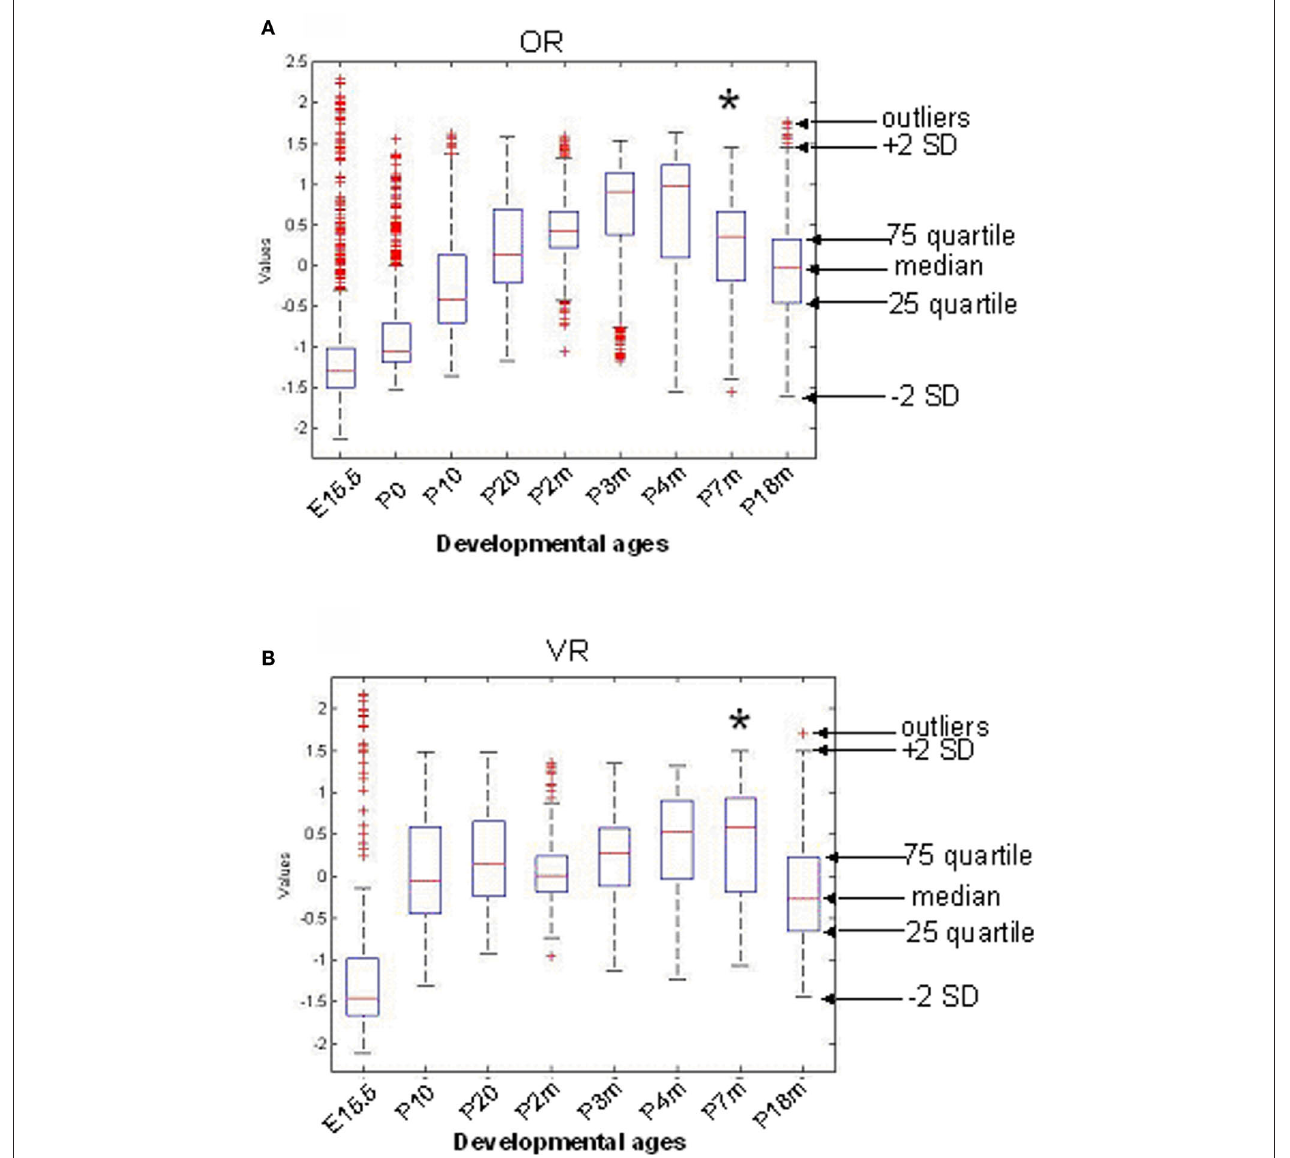
embryonic age 15.5, but was remarkably elevated before P10 (less than 2 weeks time). The median level decreased between 7 and 18 months. Compared to ORs , the expression level change for VRs between P10 and P7m was more marginal; and the expression level decrease for VRs occurred later than ORs. Their differences in temporal expression patterns may be due in part to their distinct functions in detecting environmental chemicals versus social signals, necessitating variant expression levels at distinct developmental